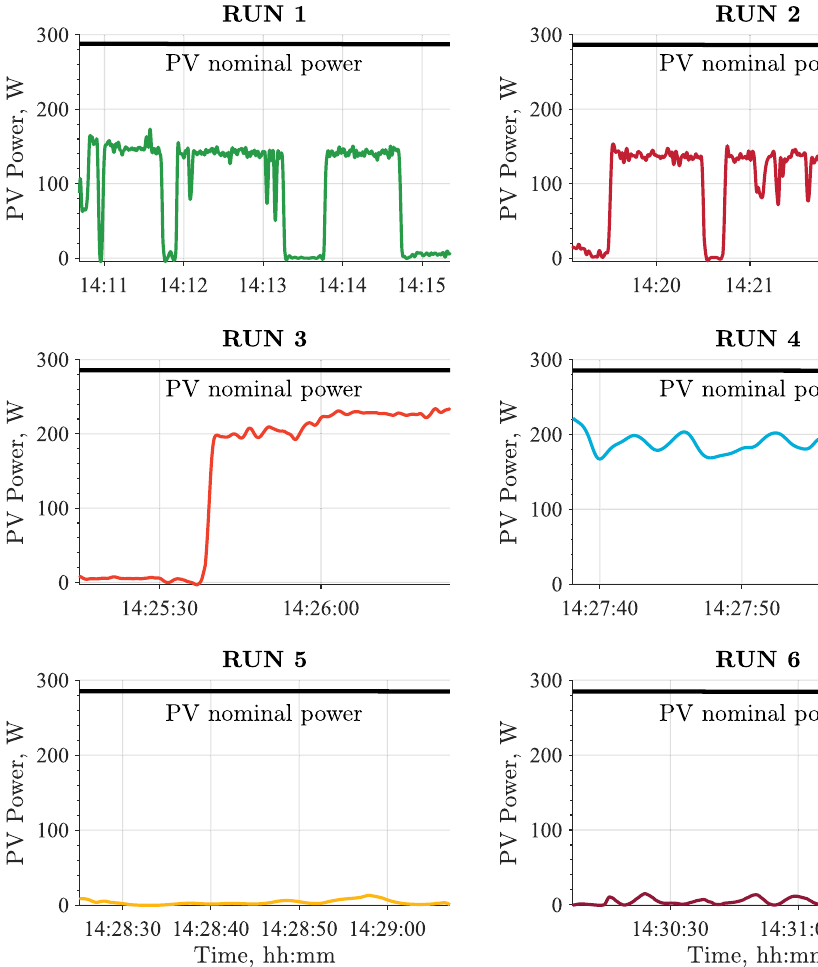
lar trajectory on a paved surface; Run 6: AWD circular trajectory on a flat grass